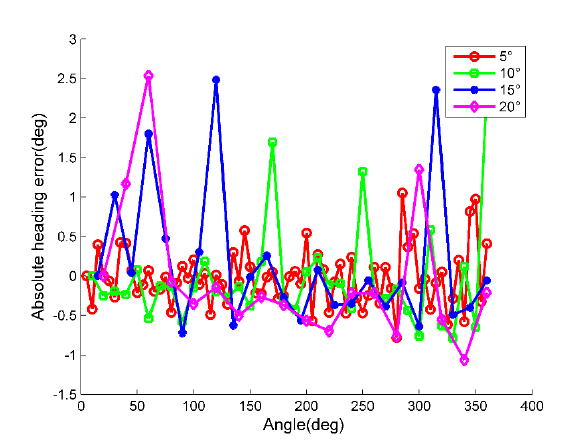
Fig.3 The results of motion angle